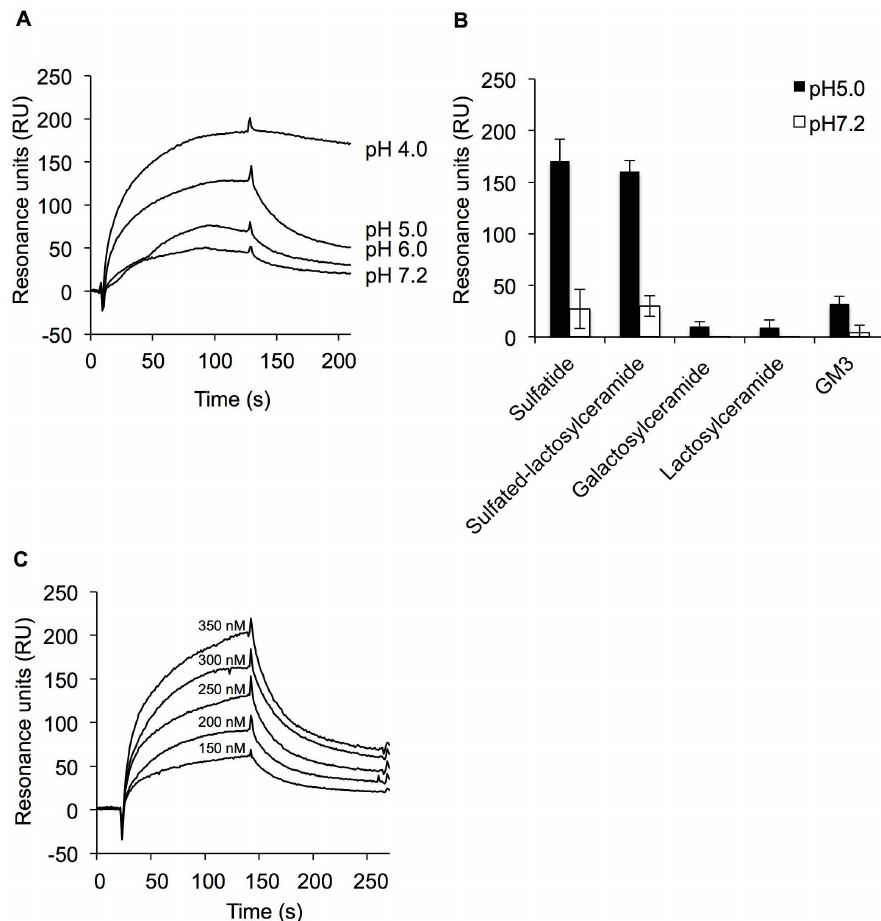
Fig 2. Binding of His 6 -EF-Tu to sulfated glycolipids assessedby SPR analysis. (A) Bindingof His 6 - EF-Tu to sulfatide (SO 3 -3Gal β 1Cer) at different pH values (pH 4.0, 5.0, 6.0, and 7.2). (B) Bindingof His 6 - EF-Tu to various glycolipids: sulfatide, sulfated-lactosylceramide (SO 3 -3Gal β 4Glc β 1Cer), galactosylceramide (Gal β 1Cer), lactosylceramide(Gal β 4Glc β 1Cer),and GM3 (NeuAc α 3Gal β 4Glc β 1Cer) at pH 5.0 and 7.2. Resonance units were measuredat the start of dissociation. Error bars indicate standarddeviations(n = 5). (C) Sensorgrams of the interactionof His 6 -EF-Tu with sulfatideat pH 5.0. Concentrations of sulfatide(from top to bottom) are as follows: 350, 300, 250, 200, and 150 nM. The K D value is describedin the